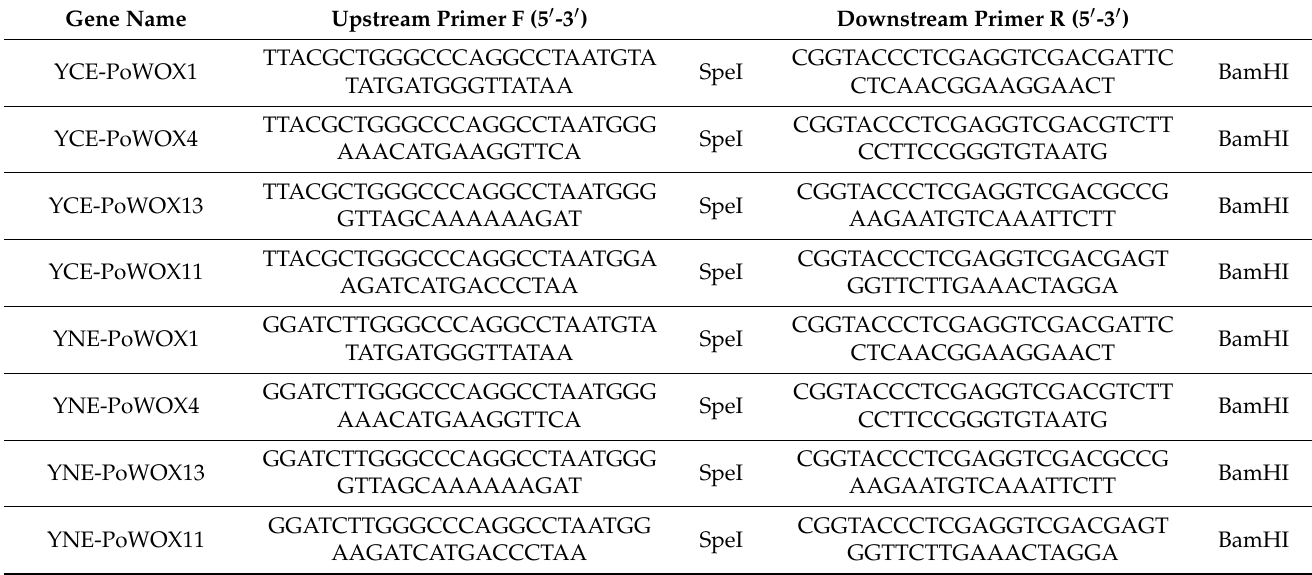
Table 5. Primer sequences for the construction of pSPYNE(R)173 and pSPYCE(MR) recombinant vectors on PoWOX genes in BiFC.